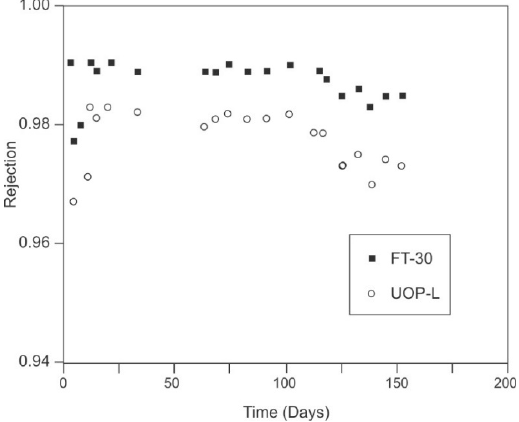
Figure 21. Rejection (reported as decimal) vs. time for DuPont-FilmTec FT-30 and Universal Oil Products UOP-L membranes. Conditions: 22 bar, pH 7.0, conductivity 6000 µS/cm with 1 ppm chlorine dioxide [342]. Reprinted with permission of Elsevier B.V.